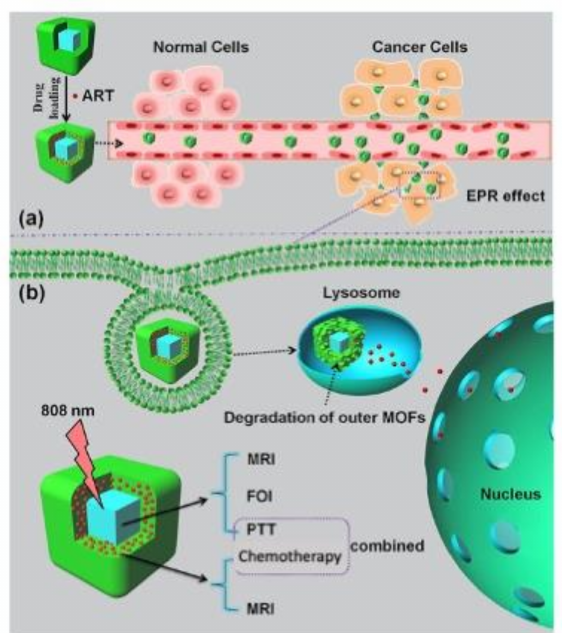
Figure 3. Picture of multifunctional nanoMOFs targeting tumors for combined therapy. ( a ) Loading and delivery process through the enhanced permeation and retention (EPR) e ff ect. ( b ) pH-responsive degradation of outer magnetic nanoMOFs for drug release and dual-modal FOI- and MRI-guided cancer therapy in vitro and in vivo. Reprinted with permission from [69], copyright 2020 from Elsevier (Amsterdam, The